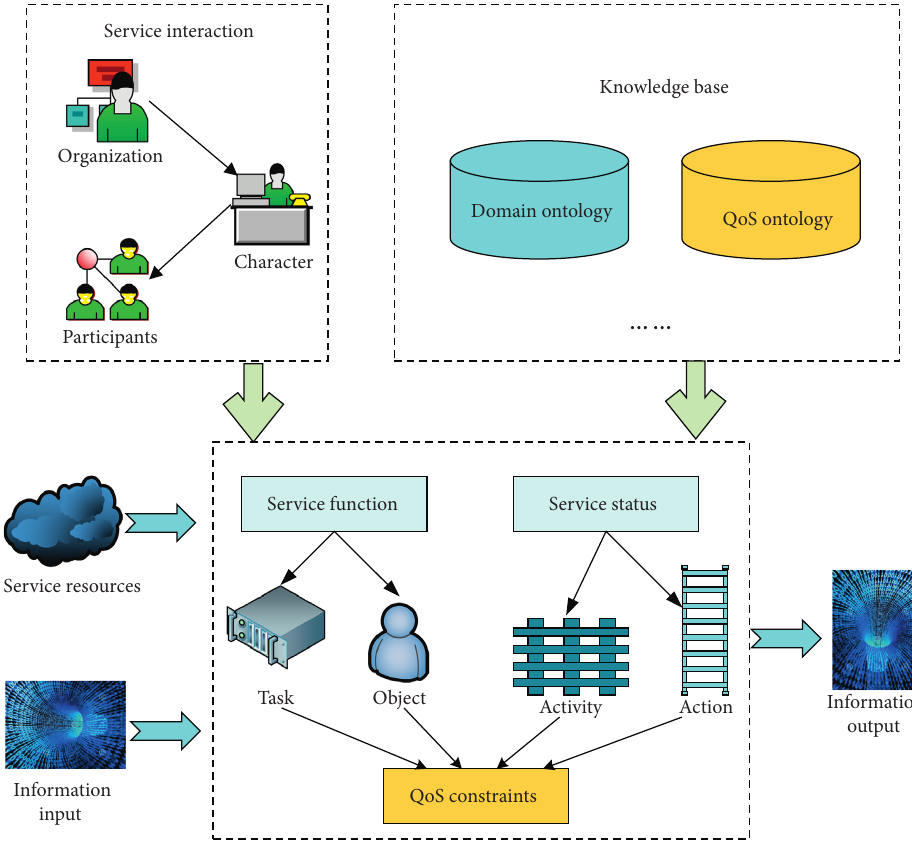
Figure 2: Service model based on